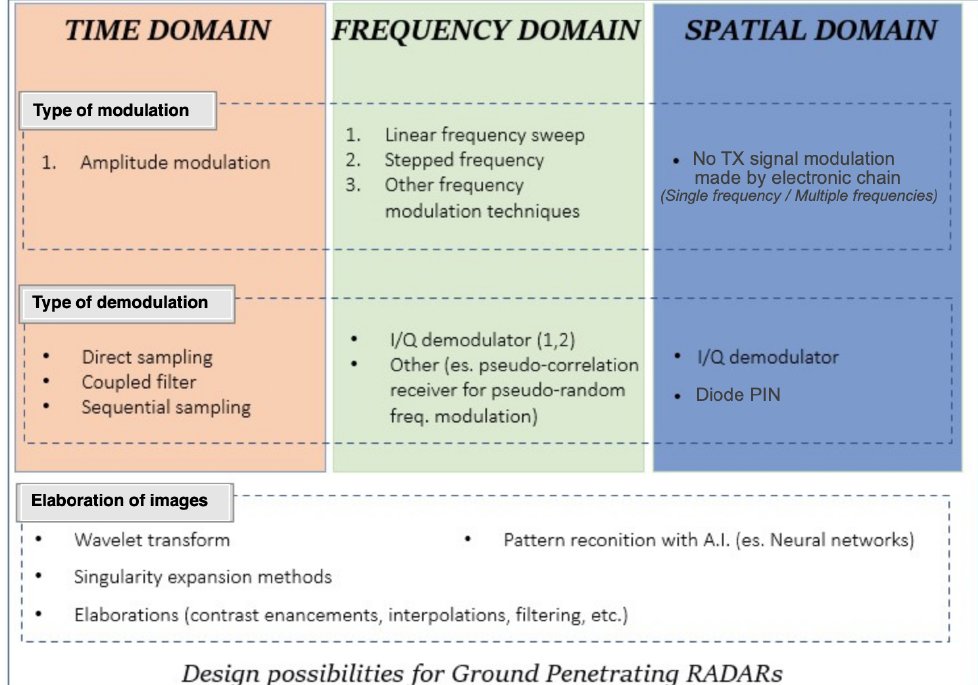
Figure 1. Methods and technolgies for GPR (Ground Penetrating